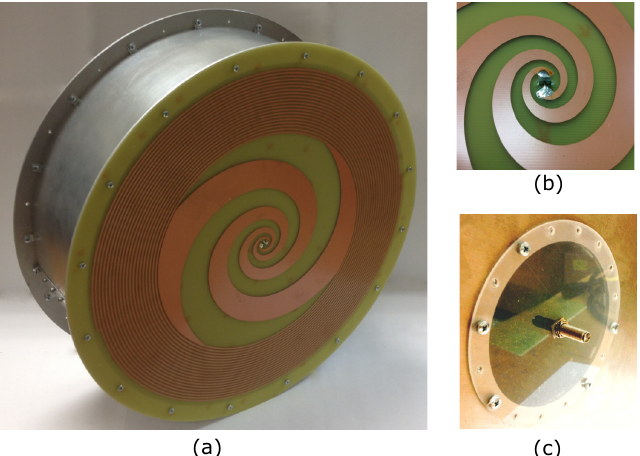
Figure 4. Assembled cavity-backed compound-spiral antenna: ( a ) front view; ( b ) spiral’s feed; ( c ) raised portion of the cavity with the mounted balun.